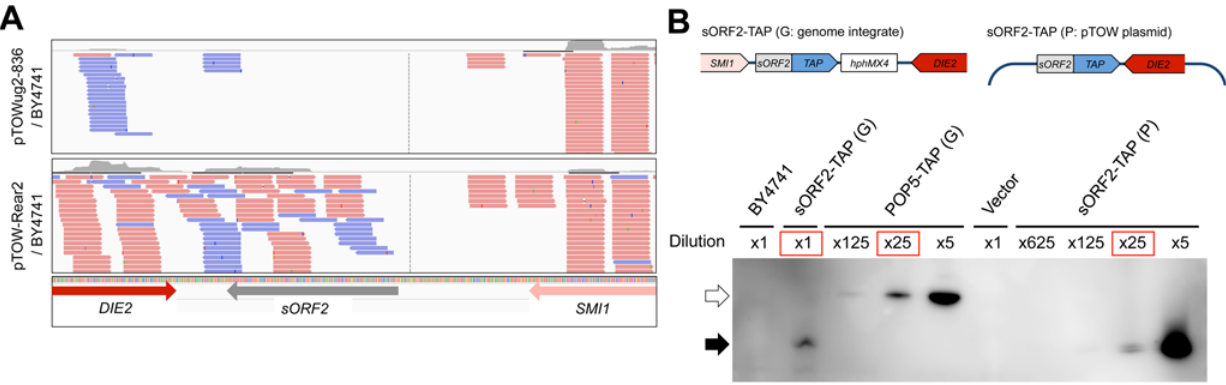
Fig 3. Expression analysis of sORF2 .